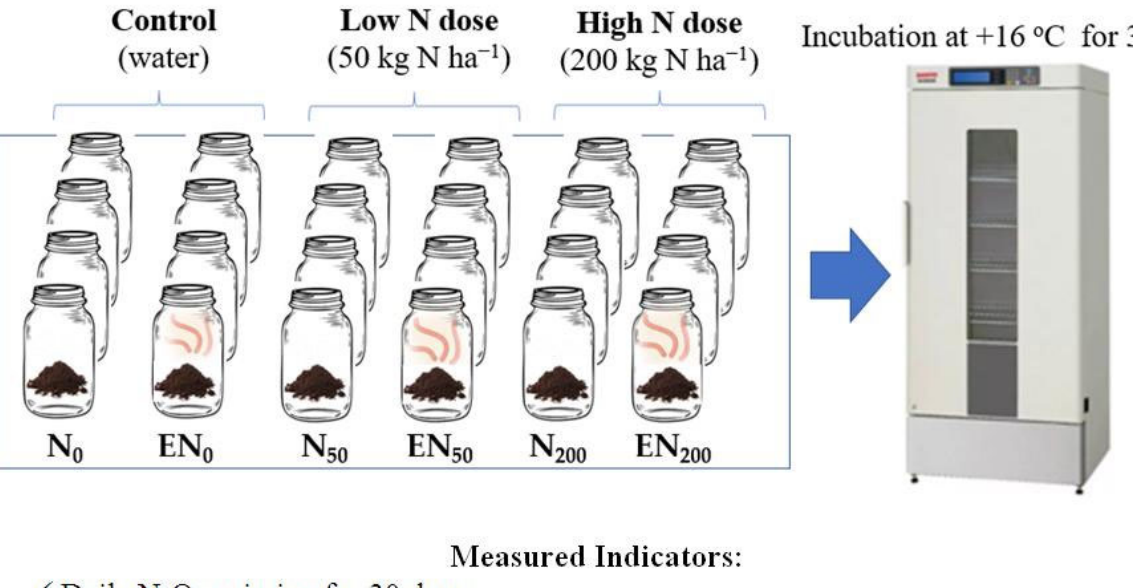
Figure 1. The experiment design scheme.